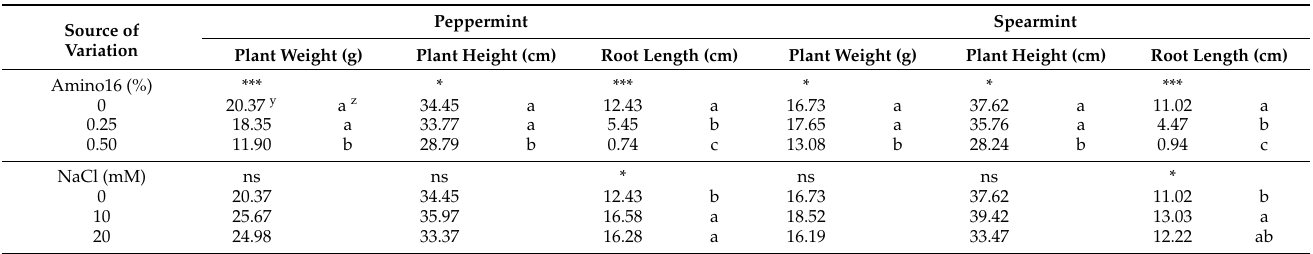
***, * or ns: Significant effect at p < 0.001, p < 0.05 or non significant, respectively, according to ANOVA. y each value is the mean of 3 replications with 16 plants per replication. z means in the same column per treatment (Amino16 or NaCl) followed by different letters are significantly different, according to the least signifcant differences test (LSD) at p <